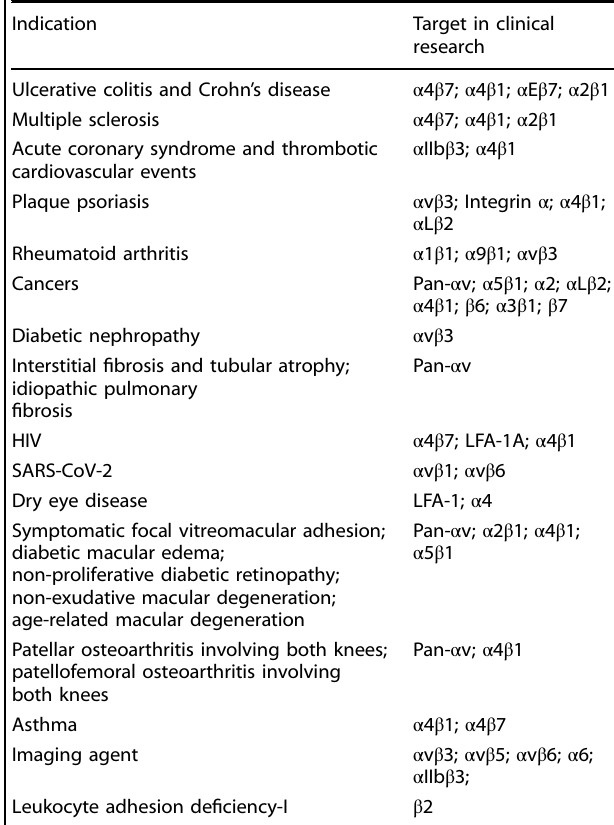
Table 2. The targeting integrin-related indications in clinical trials Indication Target in clinical